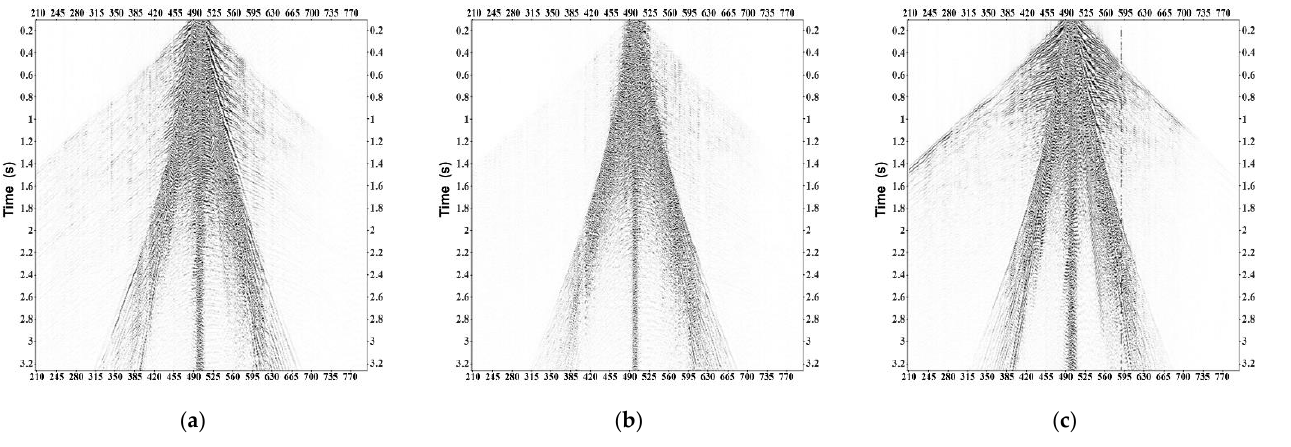
Figure 4. ( a ) The X-component wave field seismic record of the P-wave source. ( b ) The Y-component wave field seismic record of the P-wave source. ( c ) The Z-component wave field seismic record of the P-wave source.